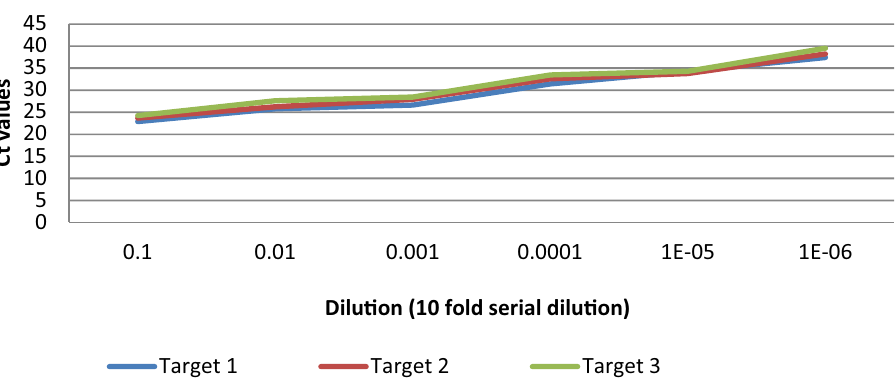
Figure 10. Graph showing average C t value obtained from five replicates for a series of 7, tenfold serial dilution of an initially tested SARS-CoV-2 positive sample. All replicates were detected up to 10 –5 dilution. No replicates were detected at 10 –7